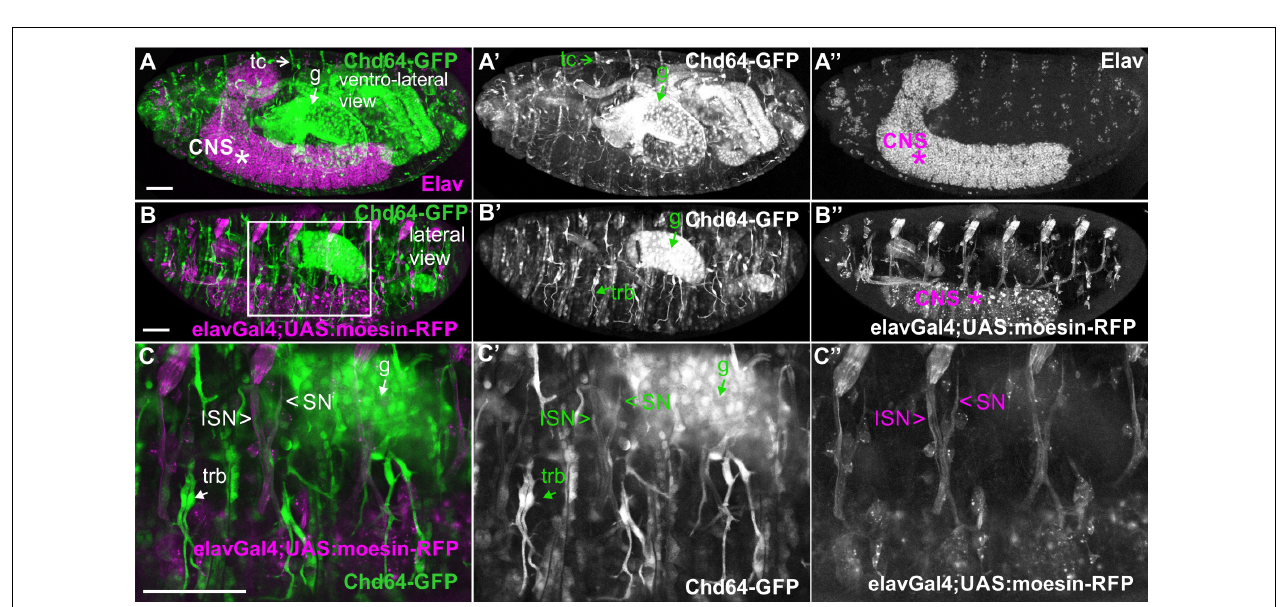
FIGURE 4 | Chd64-GFP protein accumulation in certain neuronal cells in the embryo. (A–C,A (cid:48) –C (cid:48) ,A (cid:48)(cid:48) –C (cid:48)(cid:48) ) Confocal micrographs of fixed late-stage 16 embryos expressing Chd64-GFP and (A–A (cid:48)(cid:48) ) probed with antibodies against Elav or (B–B (cid:48)(cid:48) ,C–C (cid:48)(cid:48) ) expressing UAS:moesin-RFP in the CNS (under the elavGal4 ). (C–C (cid:48)(cid:48) ) High magnification of the boxed region in panel (B) demonstrates the low Chd64 expression levels in motor neurons and peripheral neurons during embryogenesis. Each image is representative of at least four different imaged embryos of the same genotype and markers used. trb, tracheal branch; tc, tendon cell; CNS, central nervous system; g, gut; ISN, intersegmental nerve; SN, segmental nerve. Scale bars: 50 µ